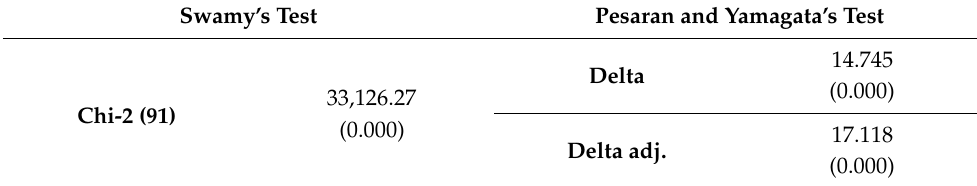
Table 8. Slope heterogeneous